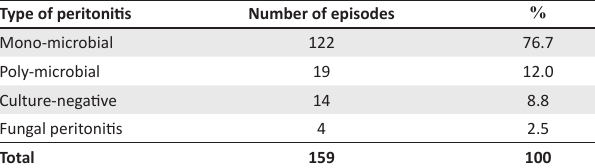
TABLE 1: Classification of microbial infections. Type of peritonitis